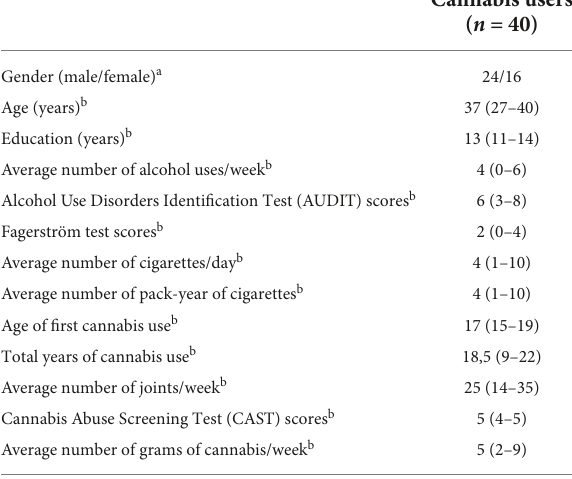
TABLE 1 Demographic and substance use characteristics of the participants at the